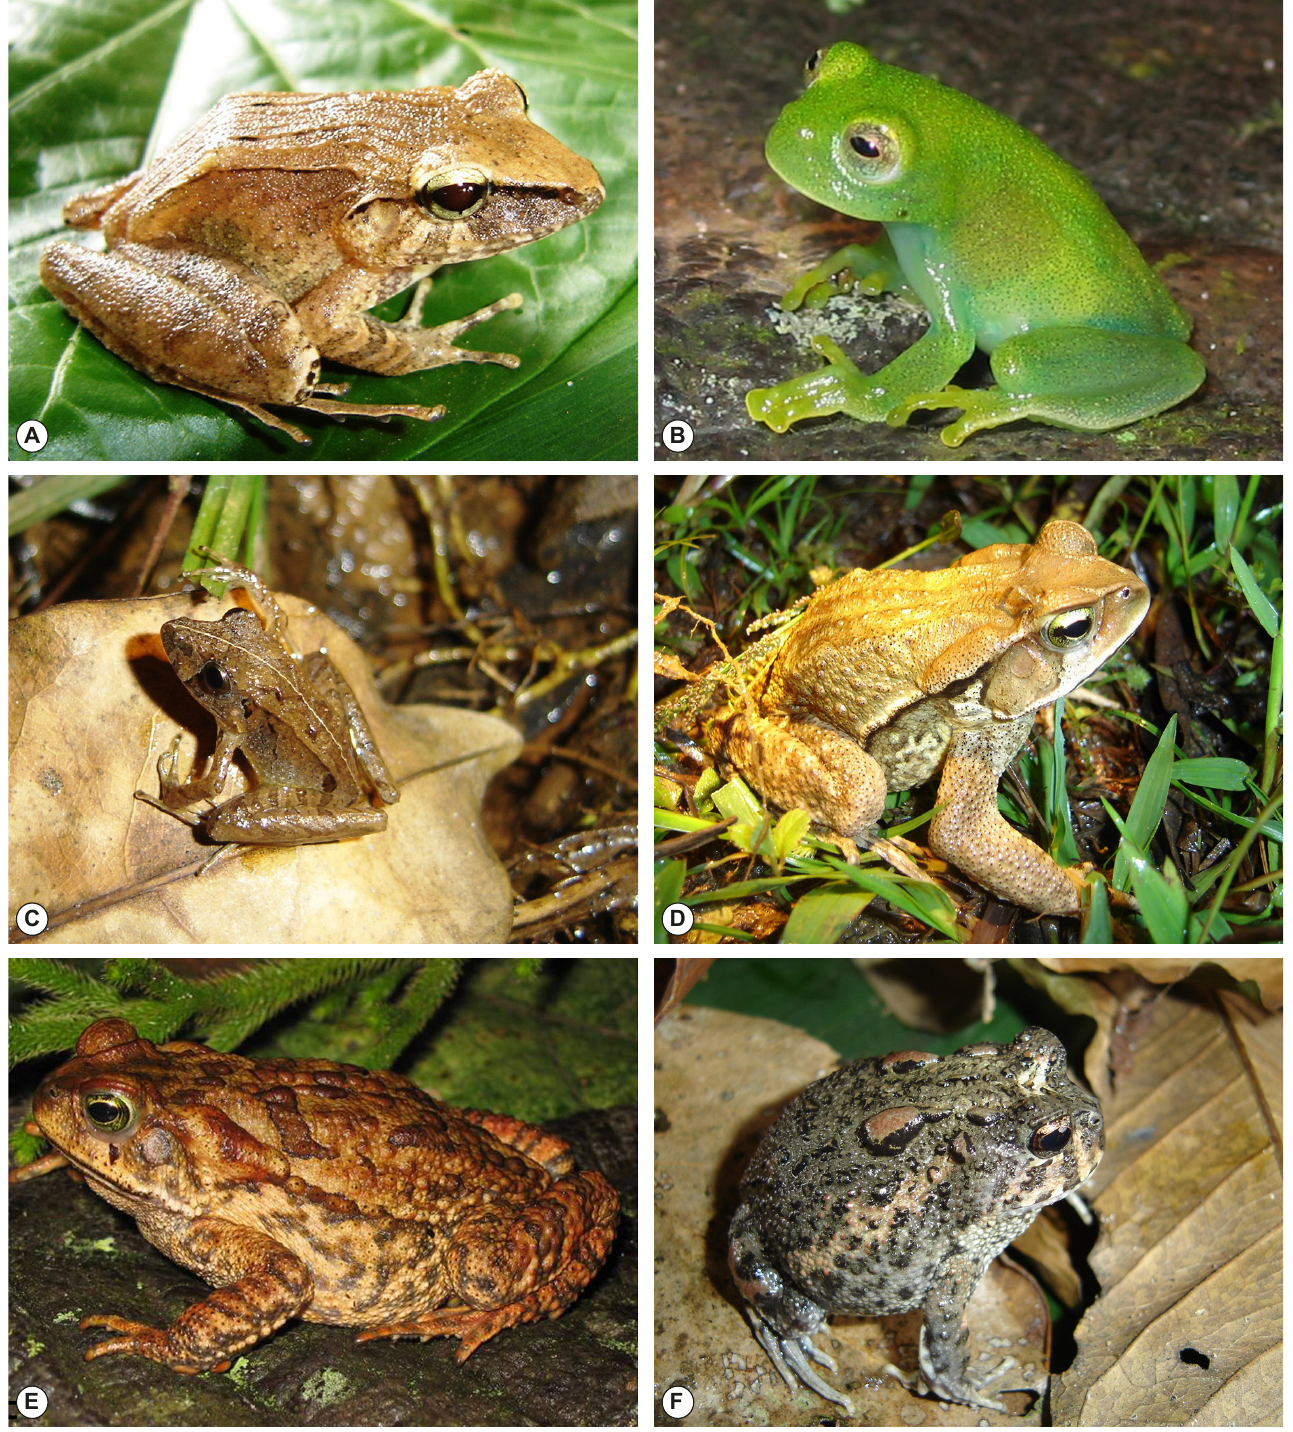
Figure 3. Some anuran species from Serra do Ouro Branco. A: